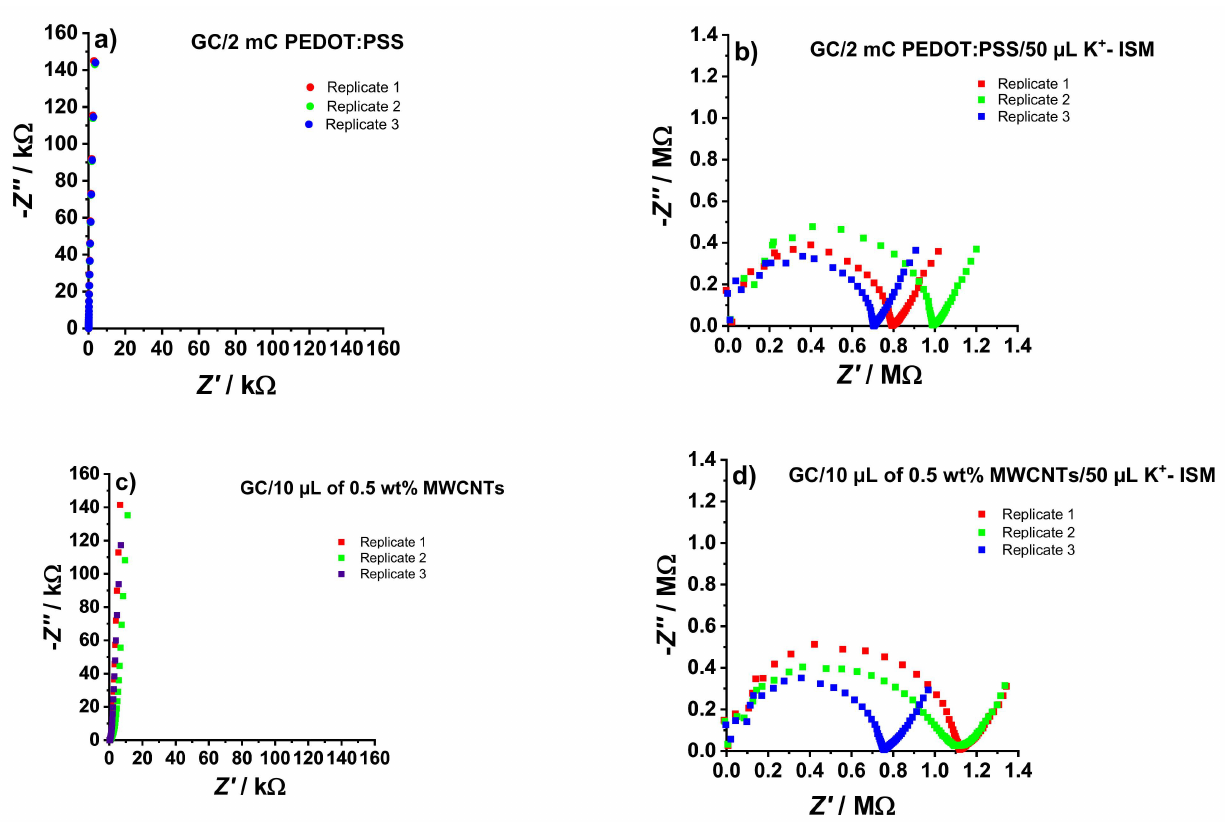
Figure 1. Electrochemical impedance spectra of PEDOT:PSS-based ( a , b ) and MWCNTs-based ( c , d ) electrodes recorded in 10 − 1 M KCl at OCP, in the frequency range of 100 kHz–10 mHz, and excitation amplitude of 10